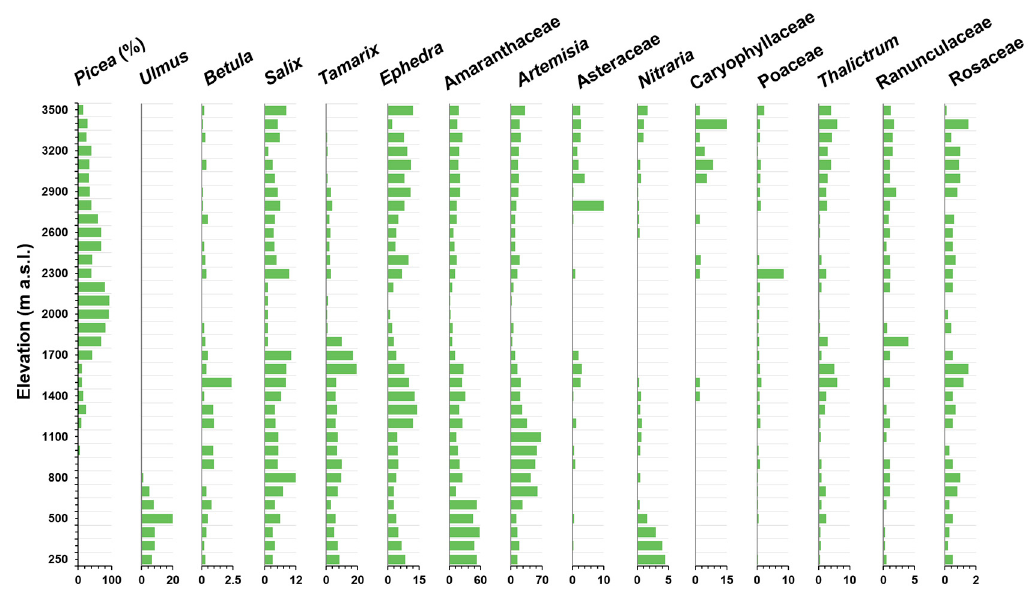
Figure 3. The richness of surface pollen taxa along the elevational gradient. Figure 3 . The richness of topsoil pollen taxa along the elevational gradient.